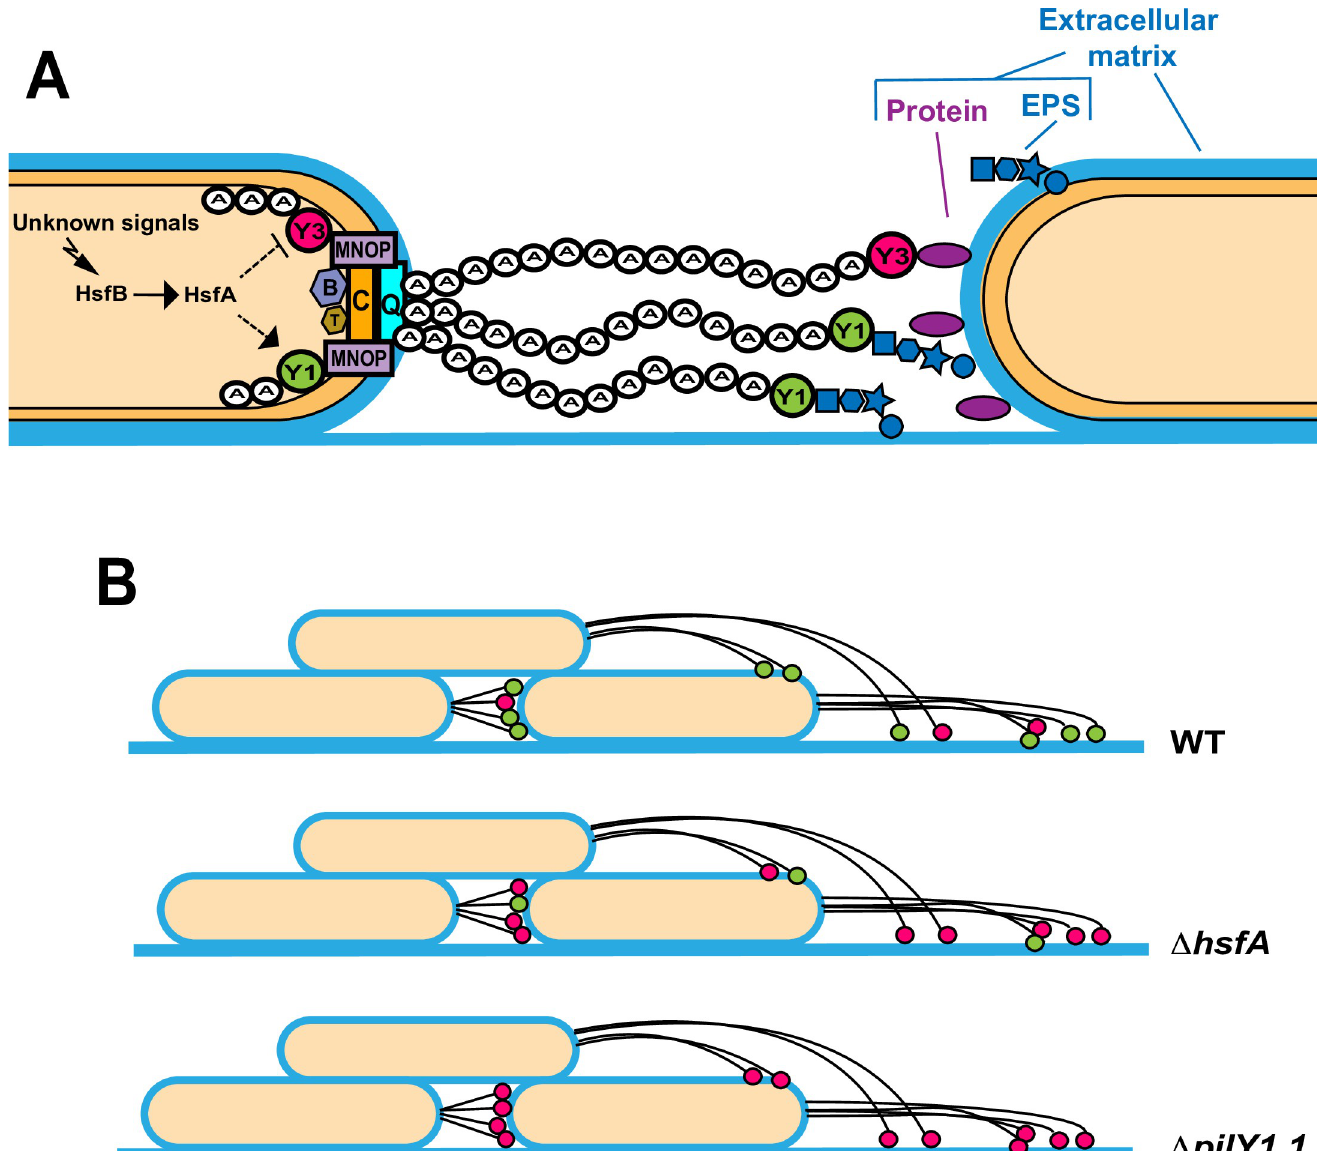
Fig 8. Proposed model on the regulation and role of PilY1 proteins. (A) Unknown environmental or metabolic signals induce the HsfBA two-component system that regulates positively the expression of PilY1.1 and negatively that of PilY1.3. PilY1.1 and PilY1.3 might be bi-functional proteins involved i) in priming T4P extension via their conserved C-terminal domains and putative interactions with cytoplasmic Pil components; ii) via their variable N-terminal domains and upon their translocation to the pilus tips, in adhering to components of the extracellular matrix deposited on the substrate or on the surface of neighboring cells. PilY1.1 might bind to EPS while PilY1.3 might bind to a different component of the matrix such as a protein or a nucleic acid. (B) In the absence ( Δ pilY1 . 1) or low amounts ( Δ hsfA) of PilY1.1, PilY1.3 could be preferentially assembled on T4P allowing motility thanks to the binding to substrates different than EPS.